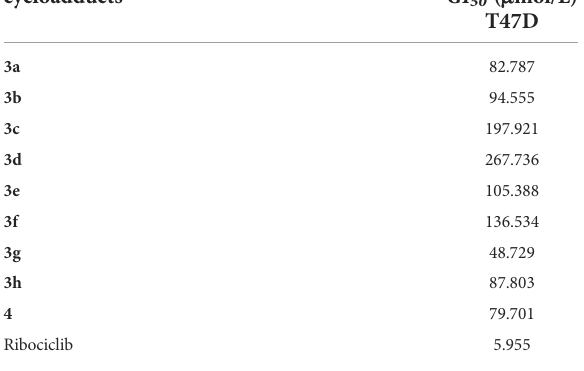
TABLE 3 The antiproliferative effects of target compounds against T47D cells ( GI 50 : m mol/L).